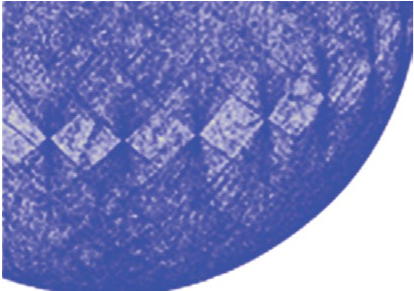
Fig. 2. Envelope of normal planes of the i th particle’s velocity vectors: a – position of the envelope in the computational space; b – full envelope; c – envelope in quasistatic equilibrium state of the mixture